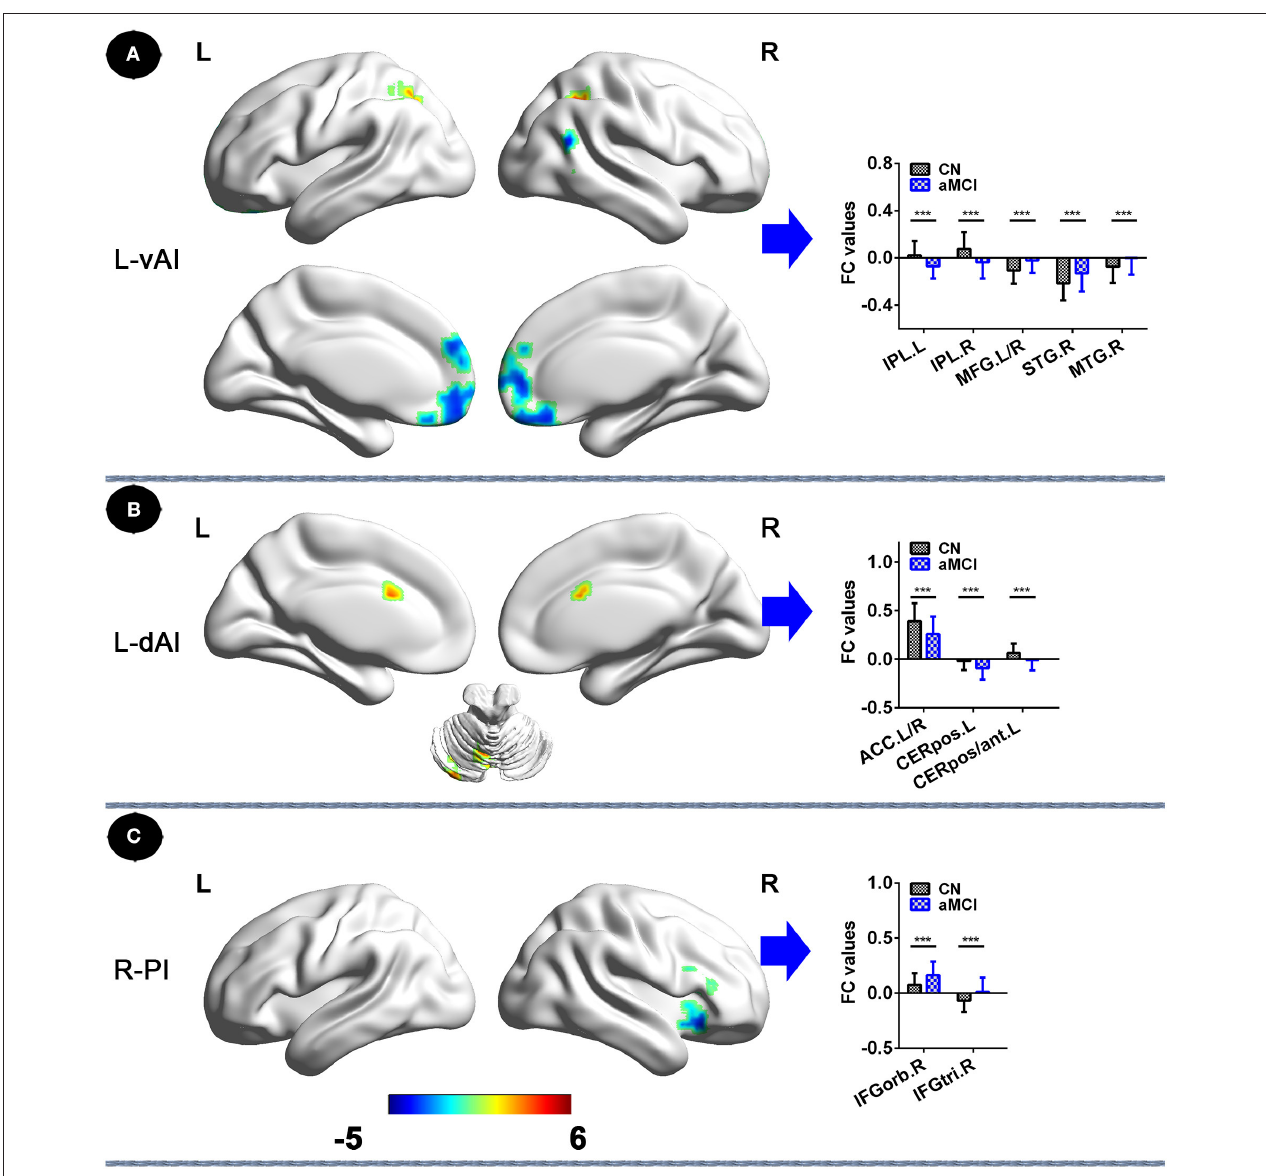
FIGURE 2 | Insular subnetwork functional connectivity in patients with aMCI compared to CNs. (A) FC of left vAI subregion between CN and aMCI patients. A bar chart indicating the quantitative comparison of FC between these regions. (B) Functional connectivity of the left dAI subregion between CN and aMCI patients. A bar chart indicating the quantitative comparison of FC between these regions. (C) FC of right PI subregion between CN and aMCI patients. A bar chart indicating the quantitative comparison of FC between these regions. * P TFCE − few < 0.05. Note: only the subnetworks that show between-group differences are shown here. All results are displayed after adjusting for age, sex, education, ITV, and FD. A threshold of p < 0.05 was applied, with a TFCE-FWE correction with cluster size > 270 mm 3 . FC, functional connectivity; CN, normal controls; aMCI, amnestic mild cognitive impairment; L-vAI, left ventral anterior insula; L-dAI, left dorsal anterior insula; R-PI, right posterior insula; TFCE, threshold-free cluster enhancement; FEW, family-wise error; ITV, intracranial volume; FD, frame-wise displacement; IPL.L, left inferior parietal lobule; IPL.R, right inferior parietal lobule; STG.R, right superior temporal gyrus; MTG.R, right middle temporal gyrus; MFG. L/R, left/right medial frontal gyrus; ACC.L/R, anterior cingulate cortex; CERpos.L, left cerebellum posterior lobe; CERpos/ant.L, left cerebellum posterior lobe/cerebellum anterior lobe; IFGorb.R, right inferior frontal gyrus, orbital part; IFGtri.R, right inferior frontal gyrus, triangular part.